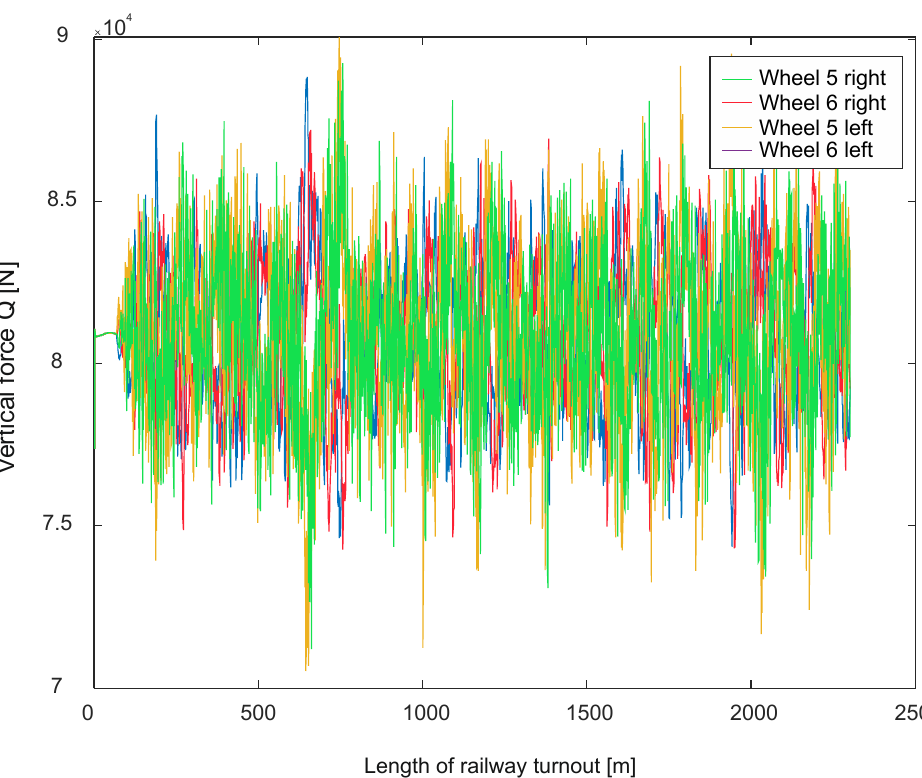
Figure 18. Vertical force at 150 km/h on a straight track without a turnout.